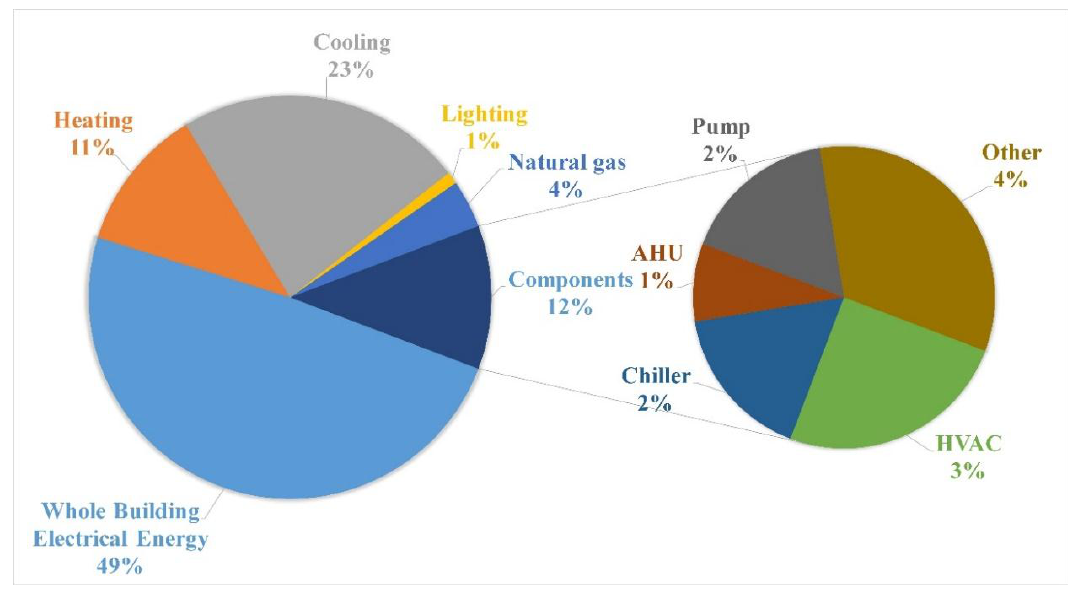
Figure 9. Percentage breakdown of target variables.